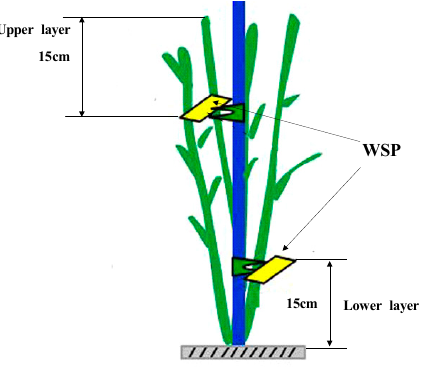
Figure 3. Upper and lower layers of water-sensitive papers (WSPs) on the sampling point.